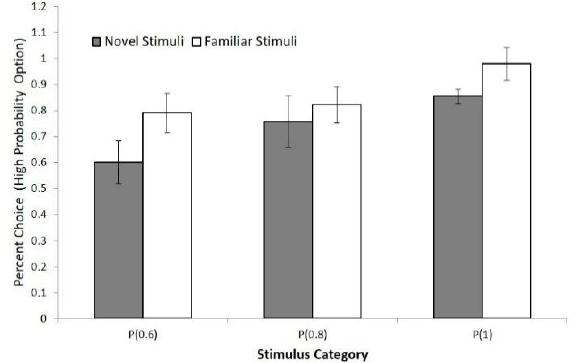
Figure 3. Percent choices for high probability winning option for the novel and familiar stimuli obtained during the main experiment, collapsed across all outcome probabilities. Error bars indicate standard deviations. Table 1. ANOVA for the conjunction analysis: all conditional stimuli (CS) (novel and familiar) vs. baseline 1